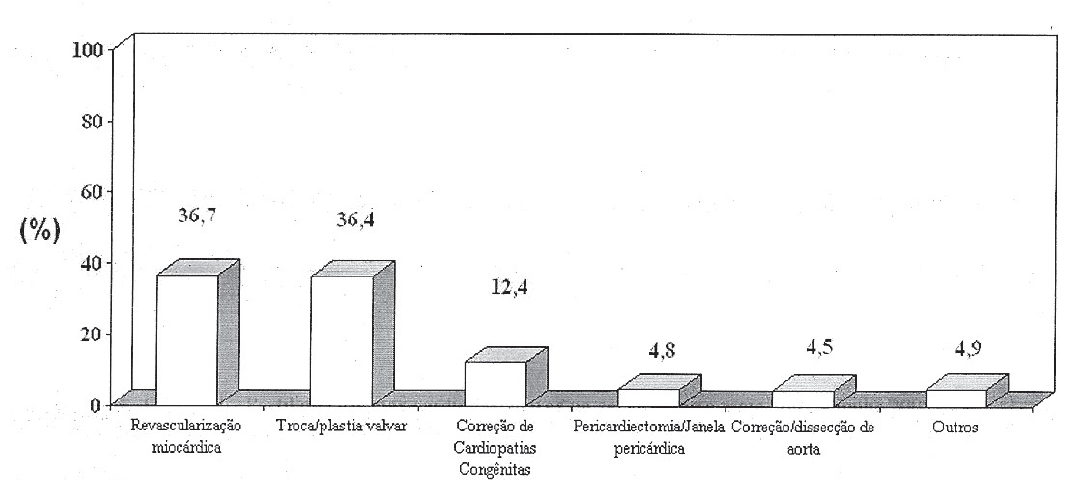
Fig. 1 - Perfil de cirurgias no serviço entre maio/2007 a